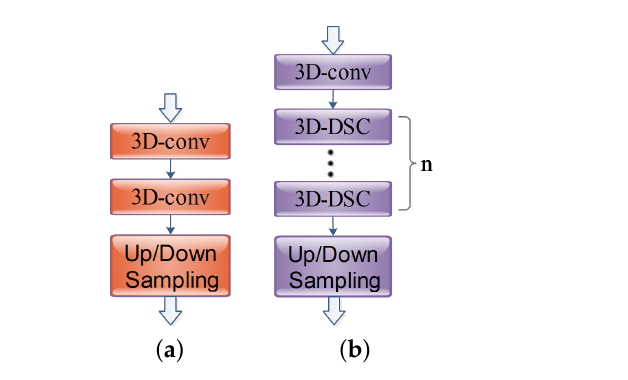
Figure 4. The basic block of normal 3D CNN (shown in ( a )) and the basic block of the network with 3D-DSC (shown in ( b )), where we replace the second normal 3D convolution with n